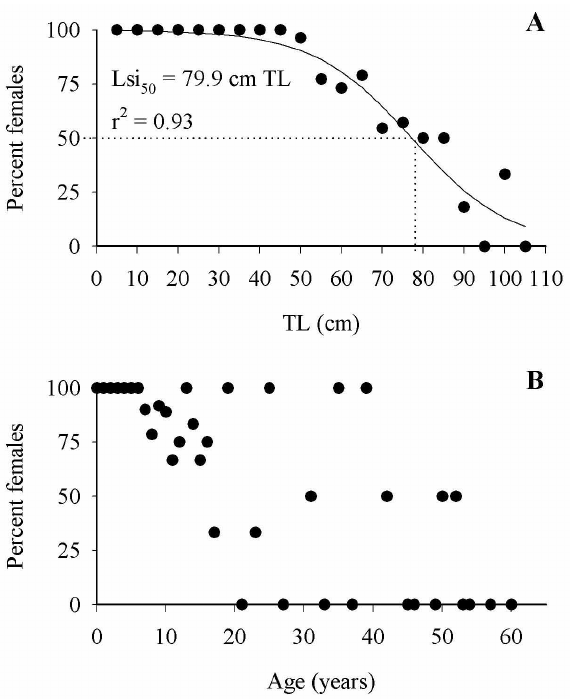
Fig . 7. – Percentage of Epinephelus marginatus females per length (A) and age (B) class. Dashed lines indicate 50% of females by length increments of 5 cm TL.